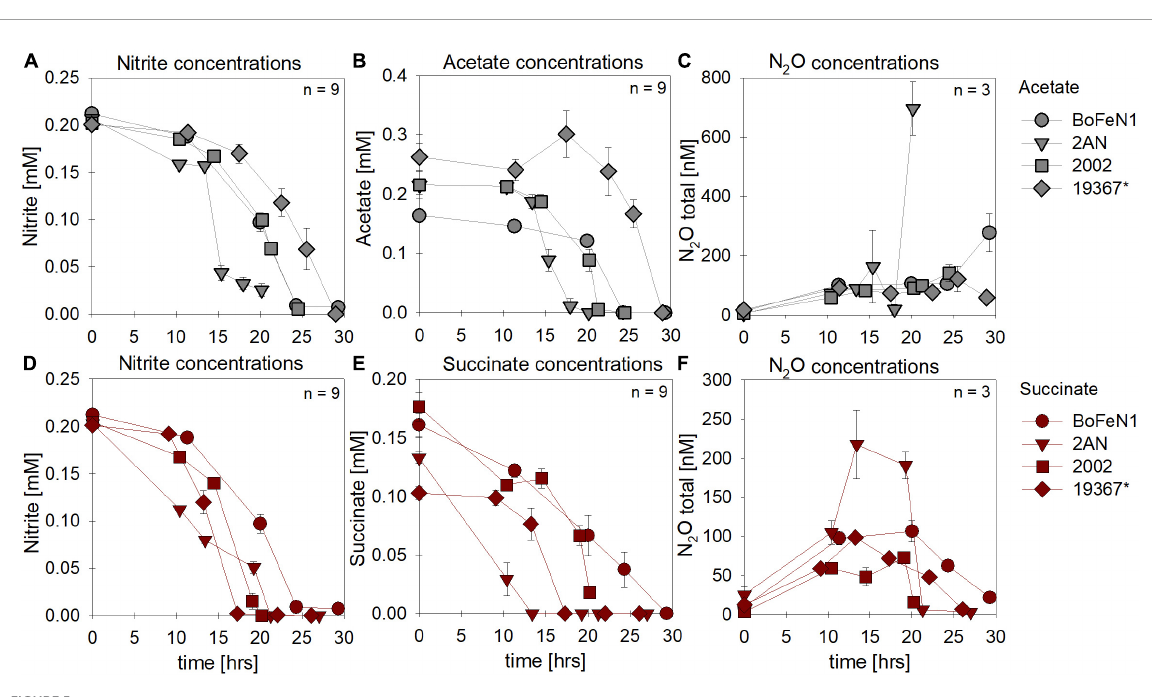
FIGURE5 Concentrations for nitrate (A,E) and organic acids [acetate (gray), succinate (red)] consumed (B,F) , N 2 O produced (C,G) and Fe(II) oxidized (D,H) during mixotrophic growth in strains of Acidovorax sp. strain BoFeN1, Acidovorax delafieldii strain 2AN, “ Pseudogulbenkiania ferrooxidans” strain 2002 and the control denitrifier (*) Paracoccus denitrificans ATCC 19367. Note that for organic acid and N 2 O concentrations different axis scales are applied. Error bars represent standard error calculated from biological replicates ( n = 9,